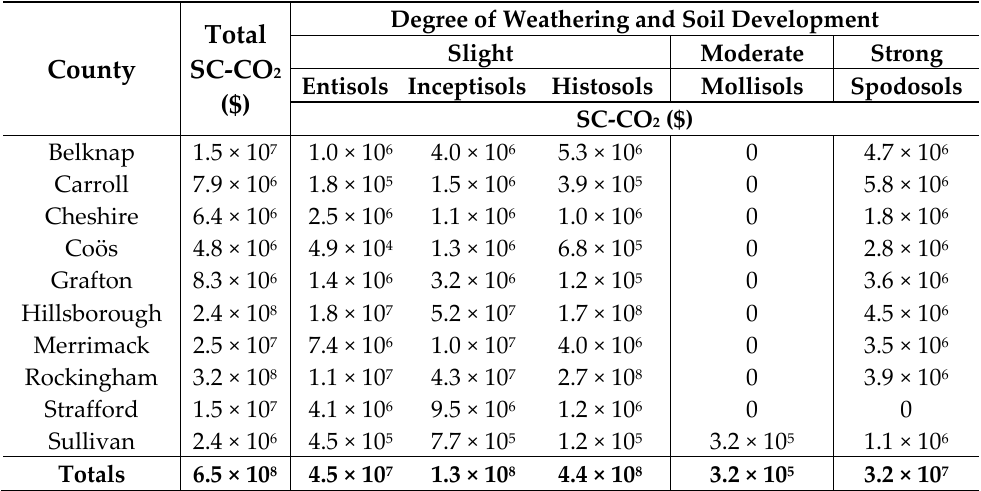
Table 14. Impacts of land development on the maximum potential realized social costs of carbon